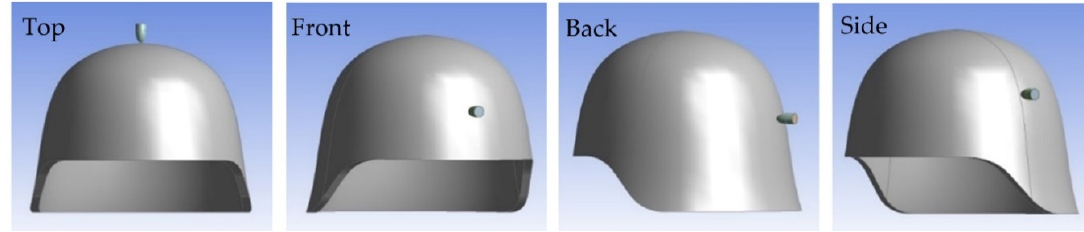
Figure 1. The geometries for ( a ) the 9 mm full metal jacketed (FMJ) bullet, and ( b ) the nanocomposite specimen.